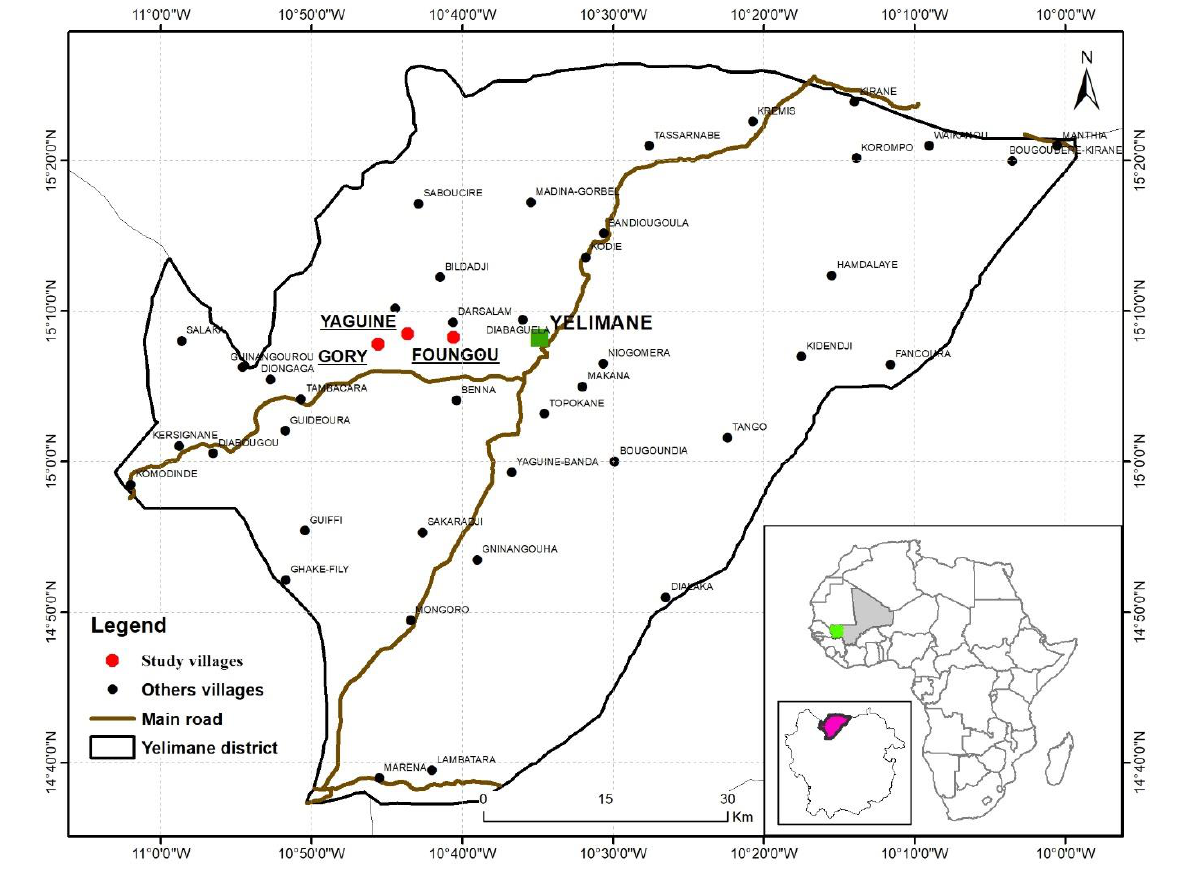
Figure 1. Map of Yelimané.